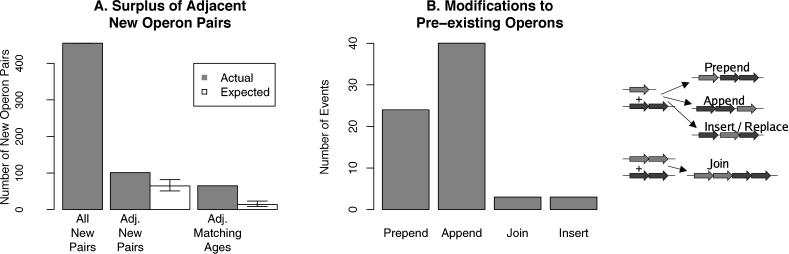
Accelerated Evolution of Some Operons(A) New operon pairs are more likely to be adjacent to each other than expected by chance. The surplus of adjacent pairs of the same age is particularly striking. The error bars show 95% confidence intervals from a c2 test of proportions. The model for random evolution is detailed in Materials and Methods.(B) The frequency of different types of modifications to pre-existing operons. The excess of append over prepend pairs is not quite statistically significant (p = 0.06, binomial test).